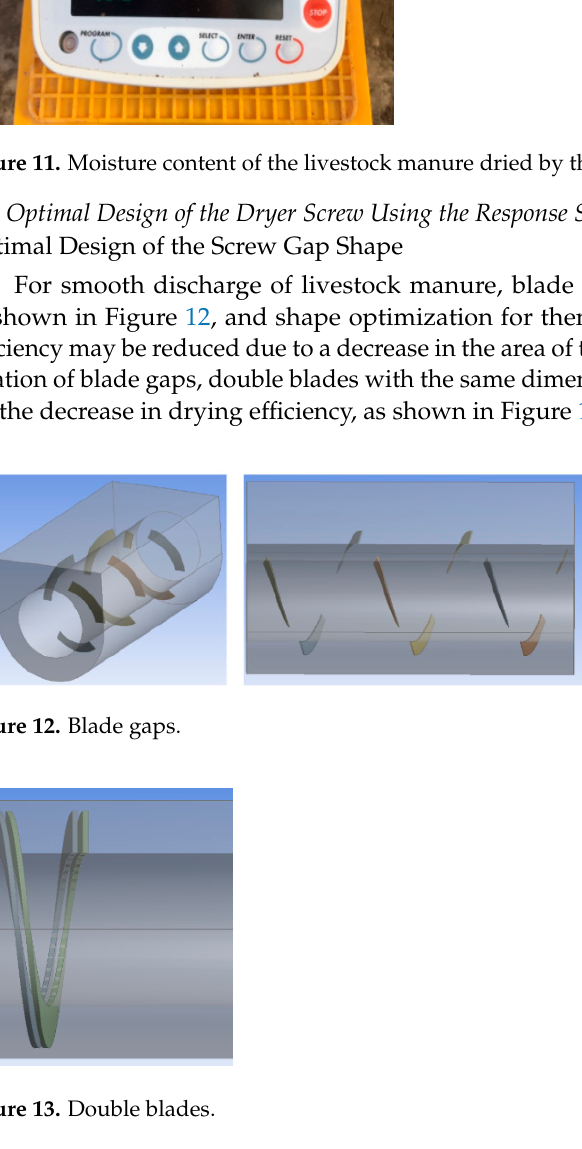
Figure 14. Arrangement in gas of left and right blades.